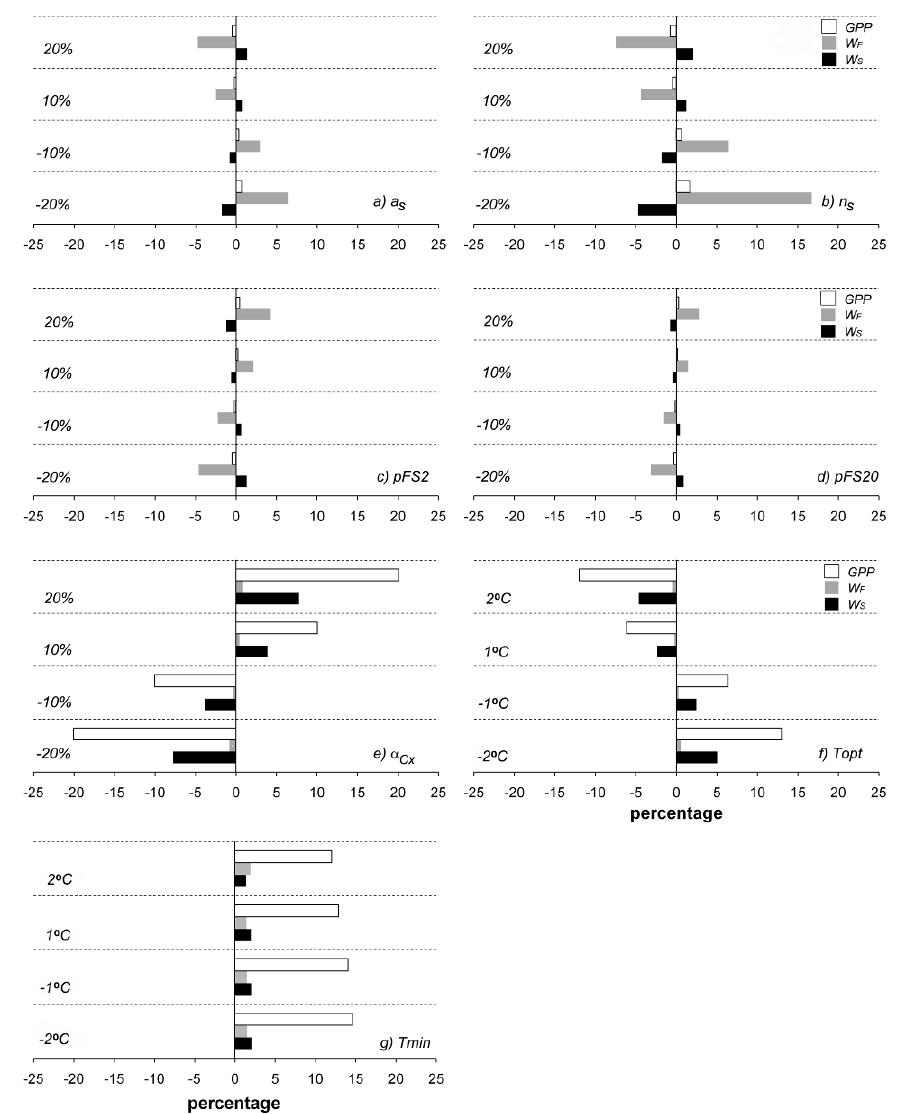
Figure 8. Sensitivity analysis of selected 3-PG outputs by changed the value of (a) stem constant: a ; (b) stem power: n ; (c) biomass partitioning ratio at DBH = 2 cm: pFS2 and s s (d) DBH = 20 cm: pFS20 ; (e) maximum canopy quantum efficiency:  ; (f) optimum Cx temperature: Topt ; and (g) minimum temperature: Tmin . The effect on the following output as stem biomass (black bar), foliage biomass (grey bar) and GPP (open bar) by changed the parameter value differed from −20 to 20%, with 10% interval. For both of Topt and Tmin, they were changed in degree Celsius as −2 °C, −1 °C, +1 °C, and +2